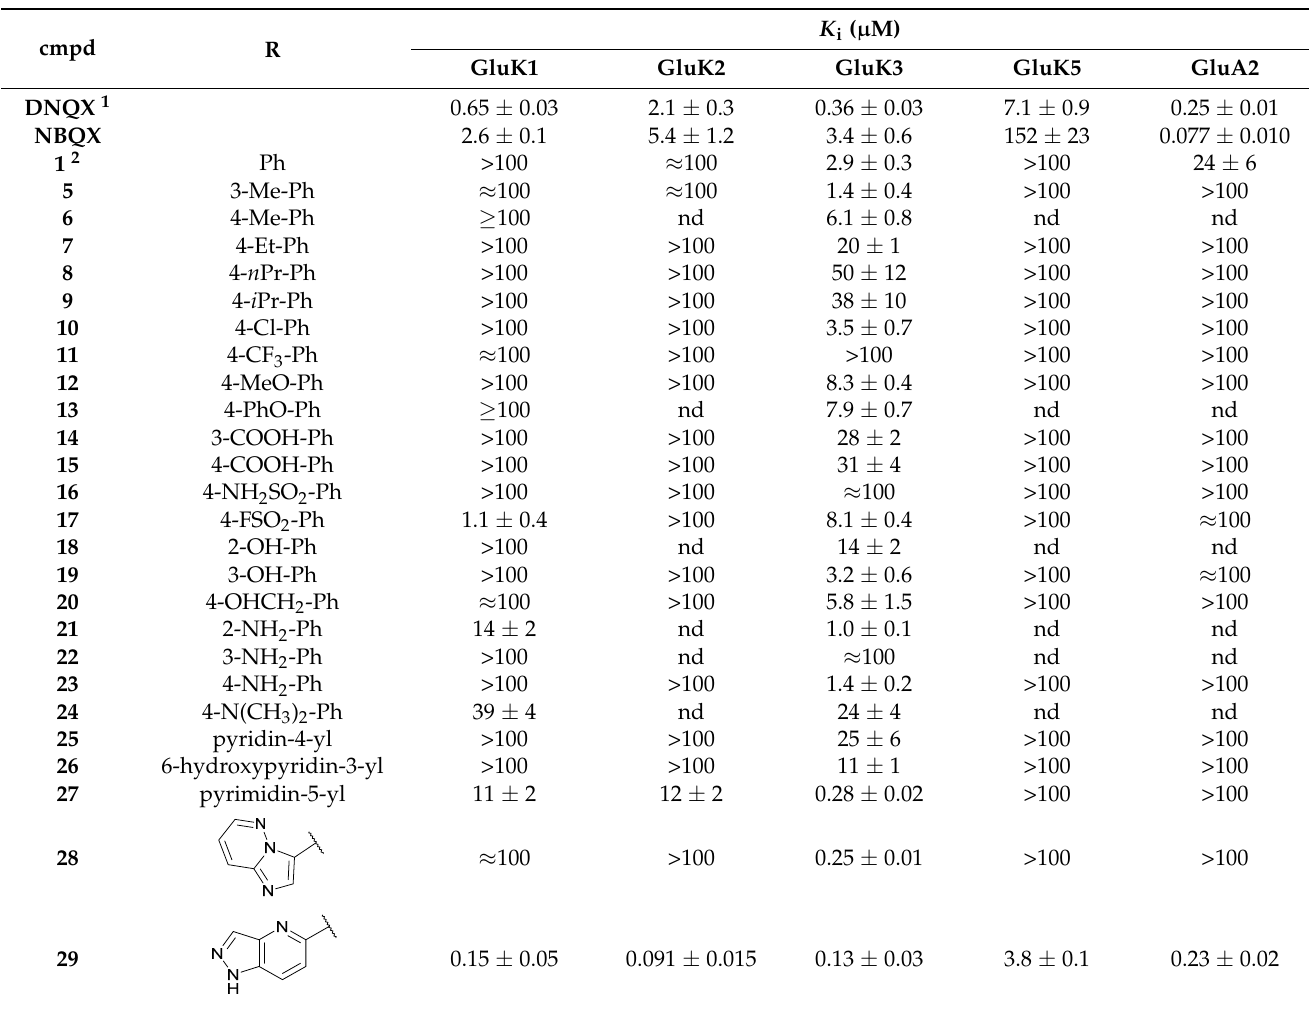
Table 1. Receptor binding affinities (mean ± SEM) at recombinant rat iGluRs.